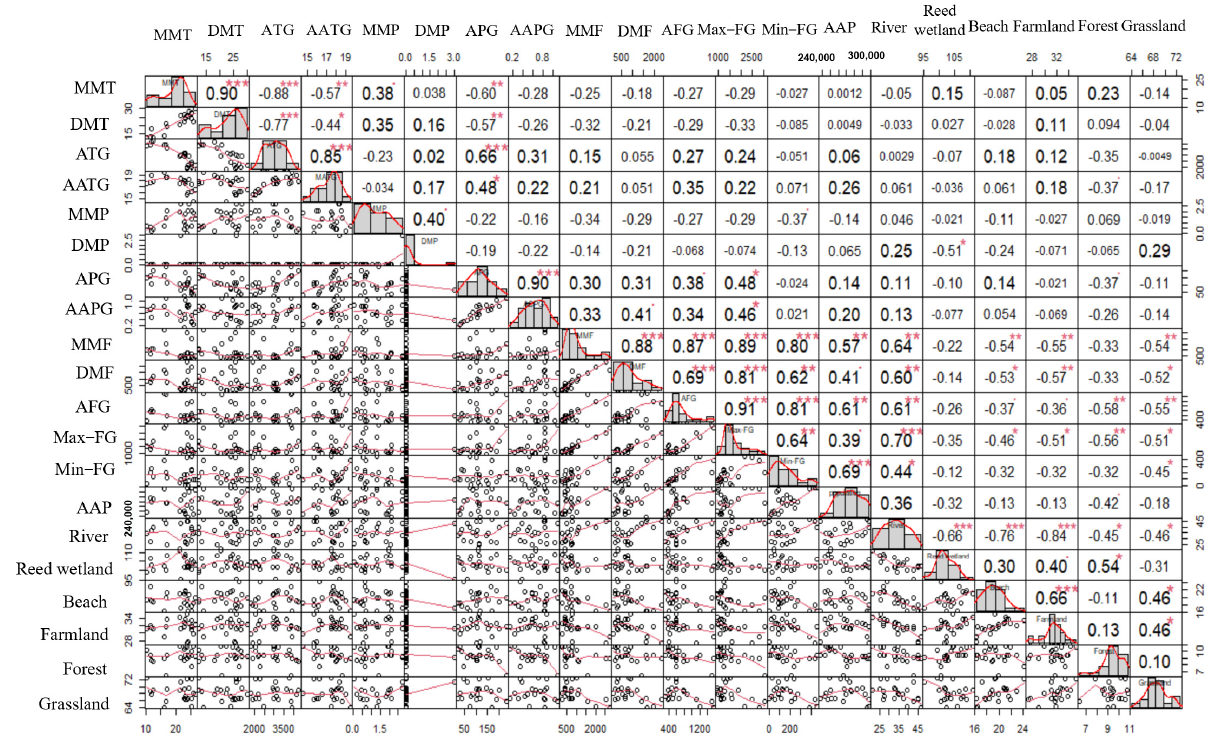
Figure 11. Correlation analysis of different wetland types and influencing factors (* means p < 0.5, ** means p < 0.01, *** means p < 0.001).